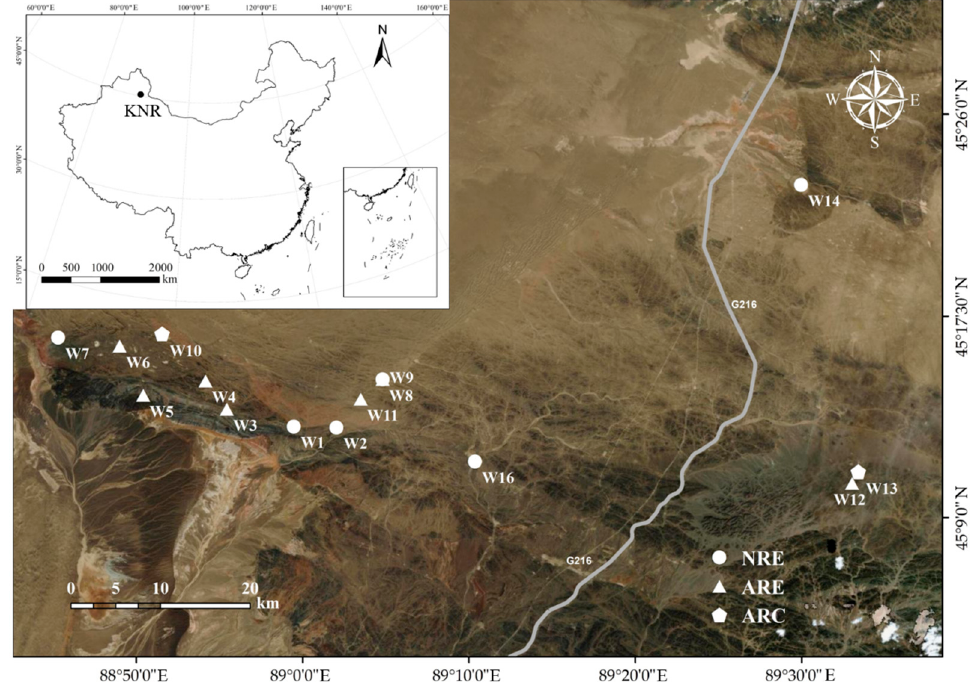
Figure 1. Locations of the sampling site for water sources in Kalamaili Mountain Ungulate Nature Reserve (KNR). Natural water sources (NRE, dots): W1 (rw1, rw2, rw3), W2 (rw4, rw5, rw6), W7 (rw7, rw8, rw9), W9 (rw10, rw11 rw12), W14 (rw13, rw14, rw15), W16 (rw16, rw17, rw18); artificial recharged water from earthen pond substrate (ARE, triangles): W3 (rh1, rh2, rh3), W4 (rh4, rh5, rh6), W5 (rh7, rh8, rh9), W6 (rh10, rh11, rh12), W8 (rh13, rh14, rh15), W11 (rh16, rh17), W12 (rh18, rh19); artificial recharged water from concrete pond substrate (ARC, pentagons): W10 (rc1, rc2, rc3), W13 (rc4, rc5,